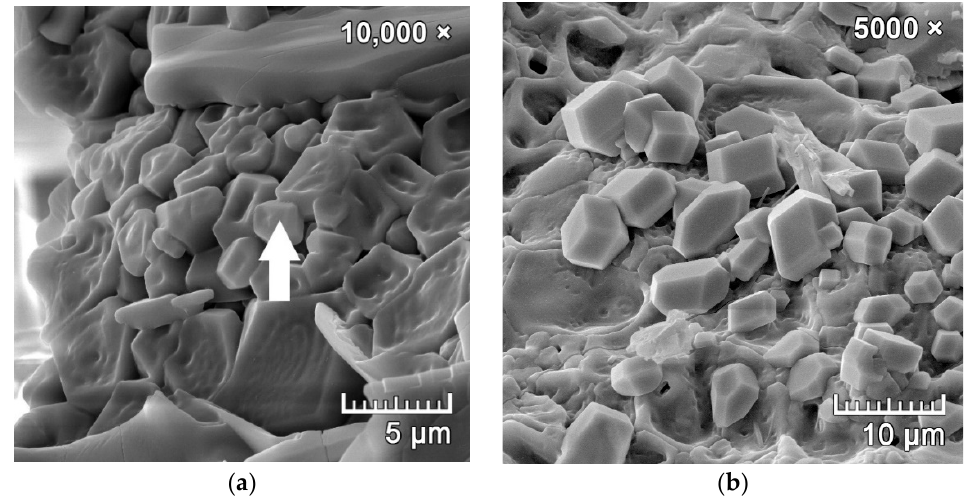
Figure 10. The microstructure of a fired CCFA-H12-17 body—( a , b ) the identification of the haüyne crystals and location of the EDX probe (arrow).